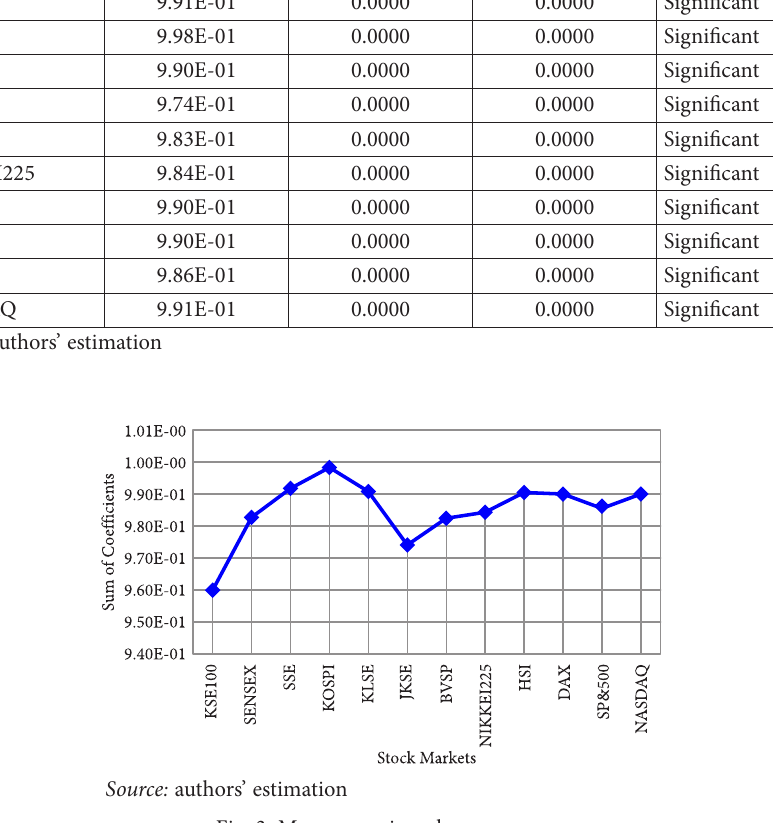
Fig. 3. Mean reversion